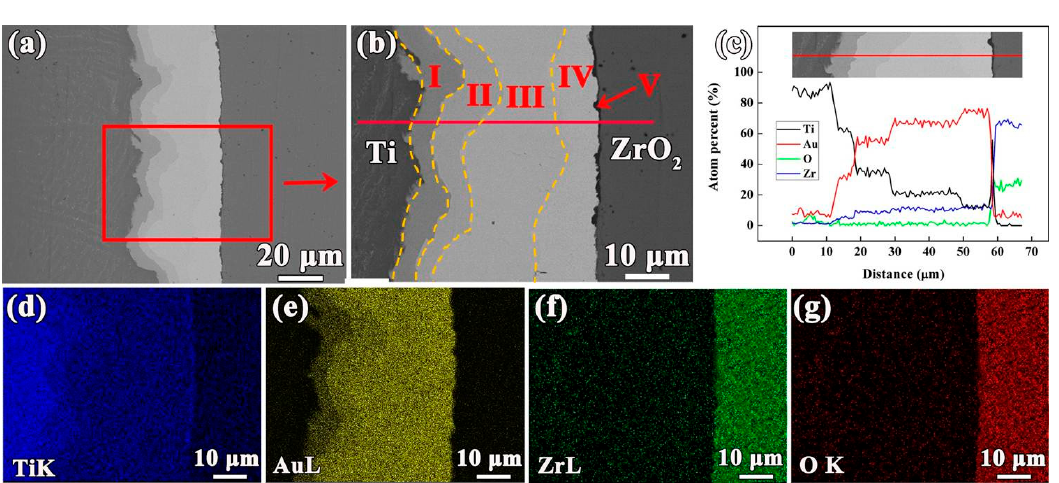
Figure 2. Typical microstructures and elemental distribution of titanium/Au/ZrO 2 joint at 1150 °C for 10 min: ( a ) lower and ( b ) higher magnification of the typical interfacial microstructure, ( c ) line distributions and ( d – g ) map distributions of Ti, Au, Zr and O.